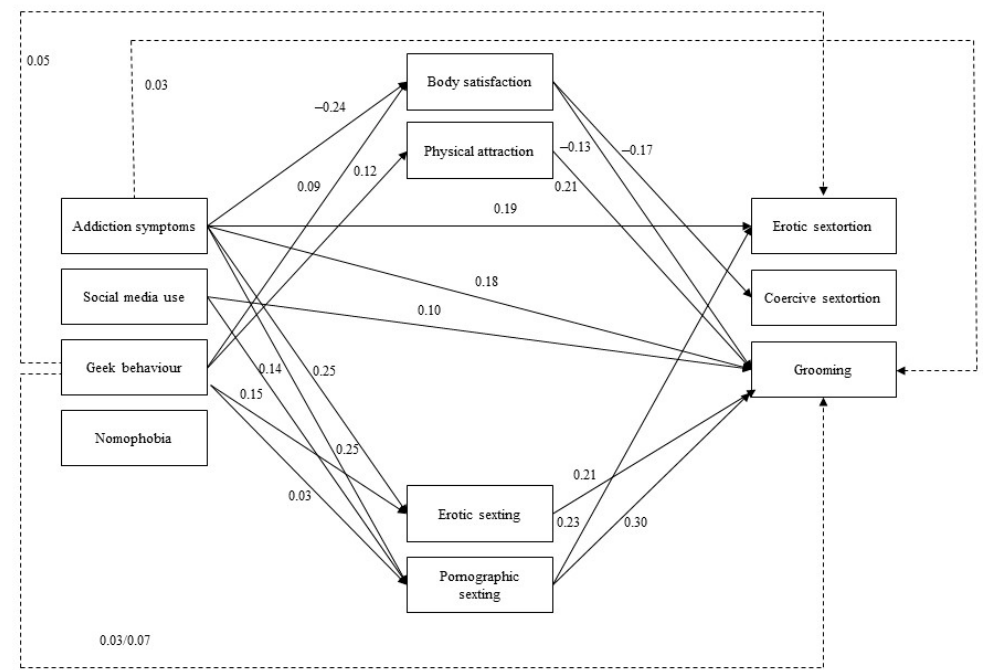
Figure 3. Tested structural equation model with partial mediation: interplay between internet and social networking addiction and sexual online victimization mediated by body self-esteem and sexting. Note . Significant effects shown as standardized coefficients ( β ); continuous pathways are significant at p < 0.01; dotted pathways indicate the indirect effects; non-significant pathways were not included.